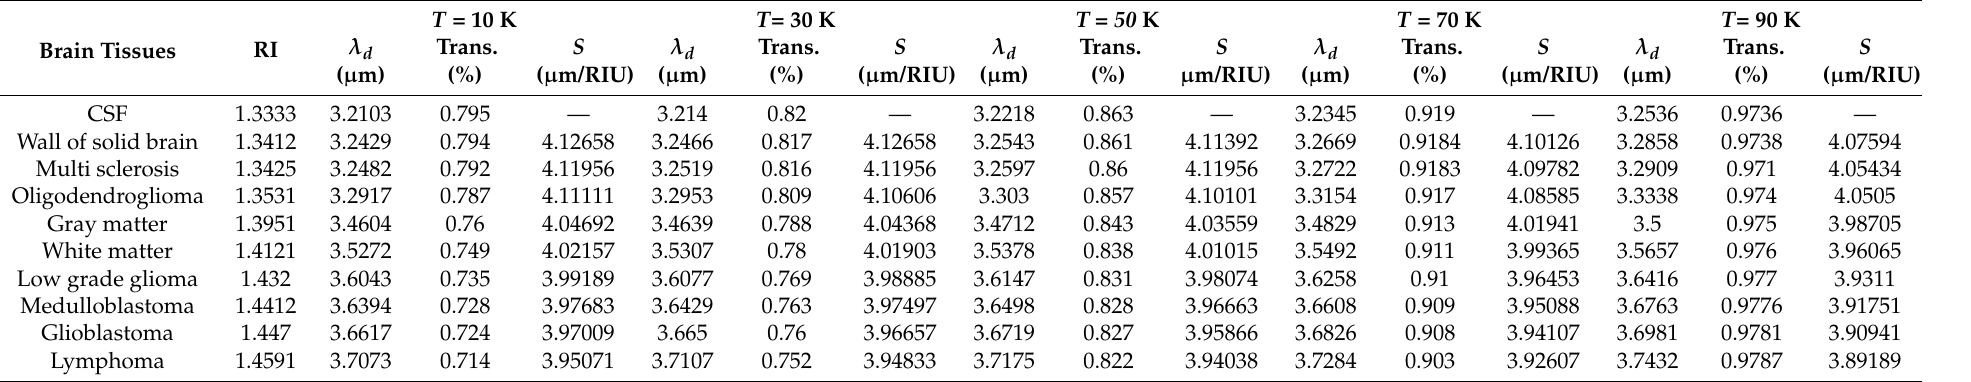
Table 3. The performance evaluation table showing central wavelength of defect mode ( λ d ), percentage transmittance of defect mode ( Trans .) and sensitivity ( S ) of the proposed design with d 4 = 15 dd , η = 0.8 and θ = 63 ◦ dependent upon different ambient temperatures of nanocomposite buffer layers ( T ) as 10 K, 30 K, 50 K, 70 K and 90 K when cavity is loaded with ten different samples containing brain